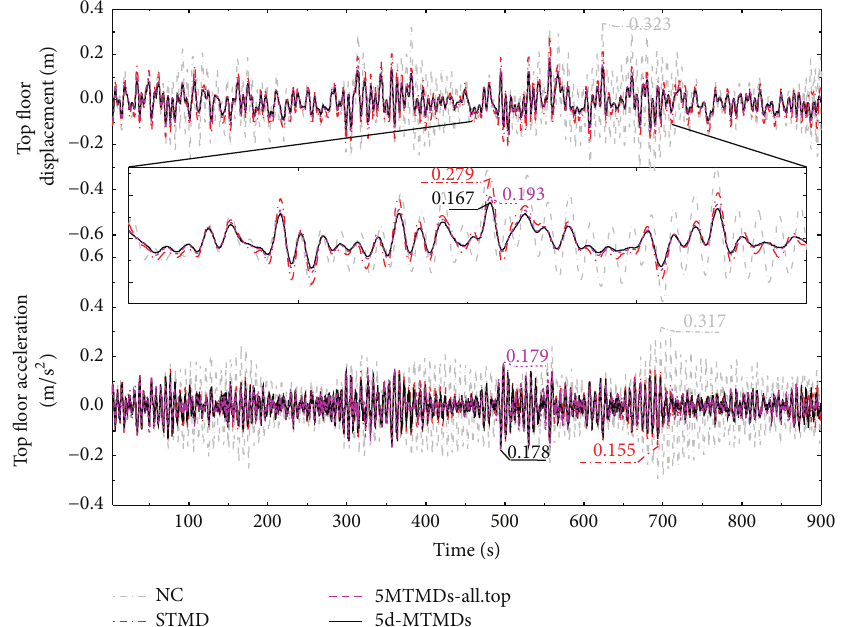
Figure 5: Time variation of top floor displacement and top floor acceleration for 76-storey benchmark building under wind forces.